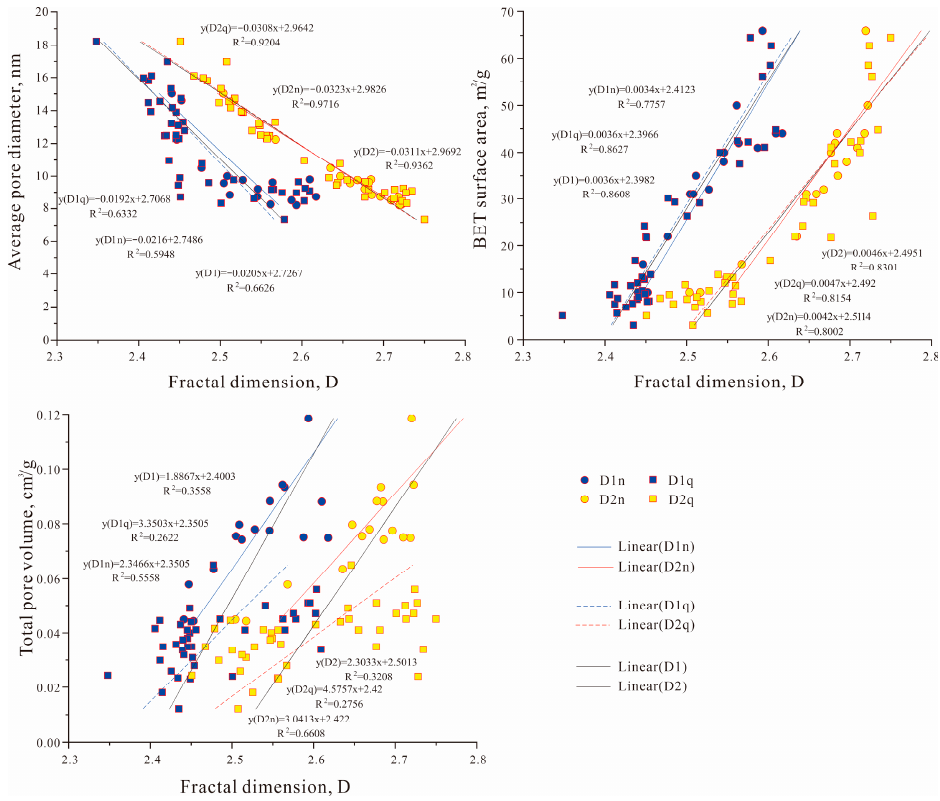
Figure 8. Relationship between fractal dimensions and total pore structure parameters of K 2 n 1+2 and K 2 q shale. The K 2 q compared to [78].